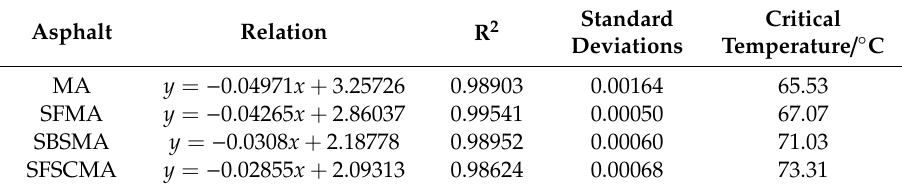
Table 10. Critical temperature of four kinds of